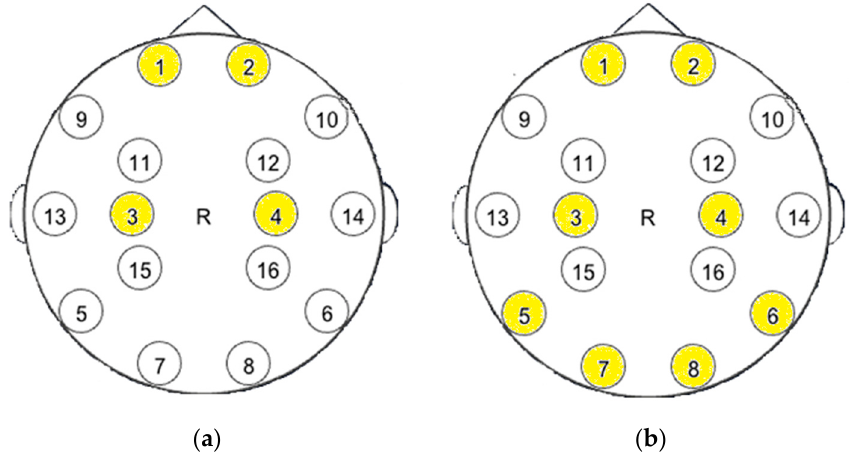
Figure 3. Scheme of the location of the electrodes: ( a ) frontal, parietal; ( b ) frontal, parietal, occipital, temporal. Yellow are nodes that were available for our version of BCI headset.